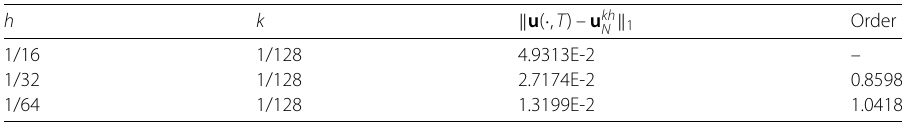
Table 2 Convergence orders of the errors with fixed time step-size h